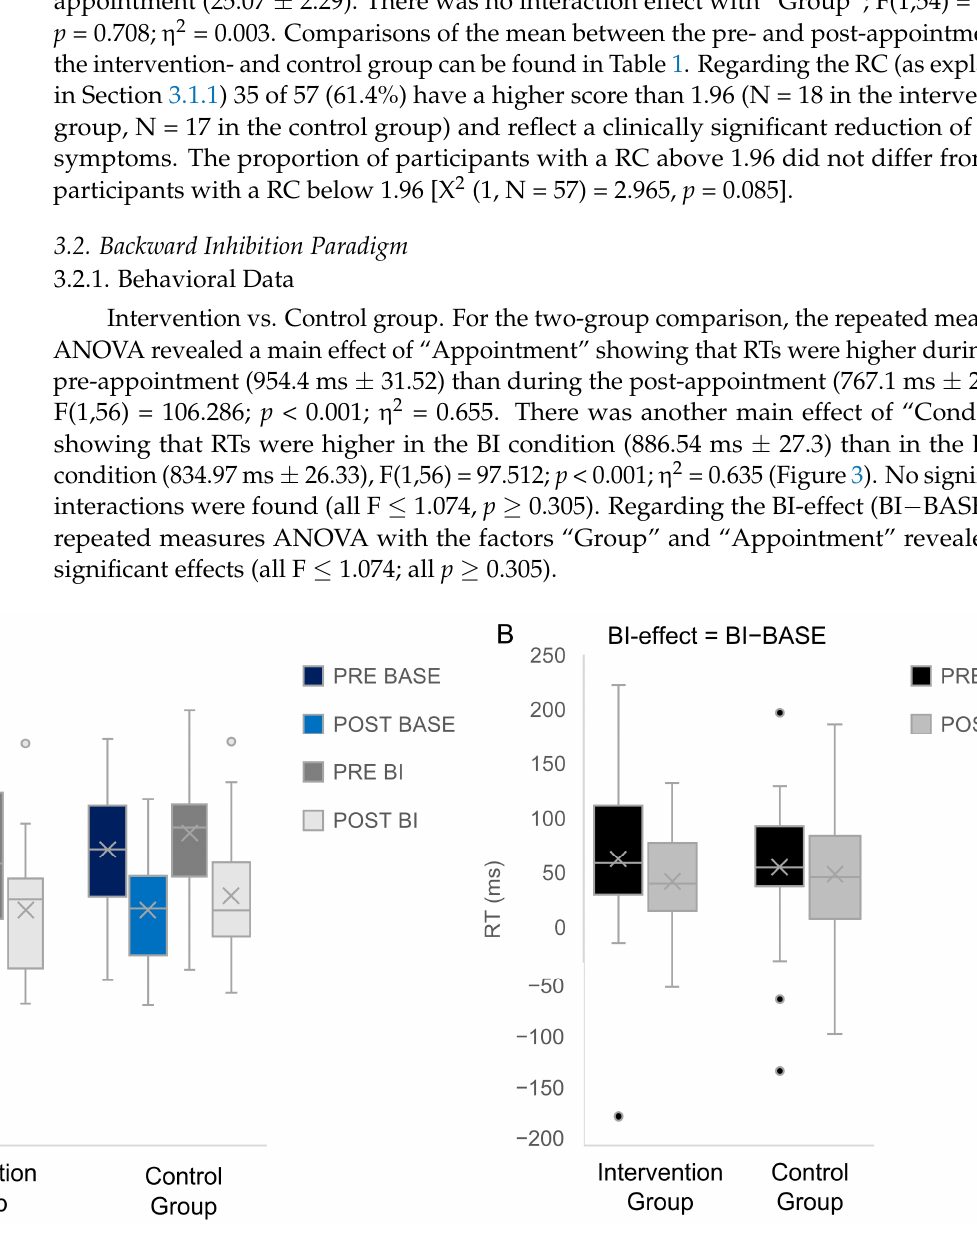
Figure 3. Reaction time data for the BI and the BASE condition in the intervention and the control group are presented ( A ). The BI-effect (i.e., BI condition − BASE condition) for the two groups is shown ( B ). Within each box, horizontal grey lines denote median values; boxes extend from the 25th to the 75th percentile of each condition’s distribution of values; whiskers above and below the box indicate the 10th and 90th percentiles (i.e., the most extreme values within 1.5 interquartile range of the 25th and 75th percentile of each condition); dots denote observations outside the range of adja- cent values.